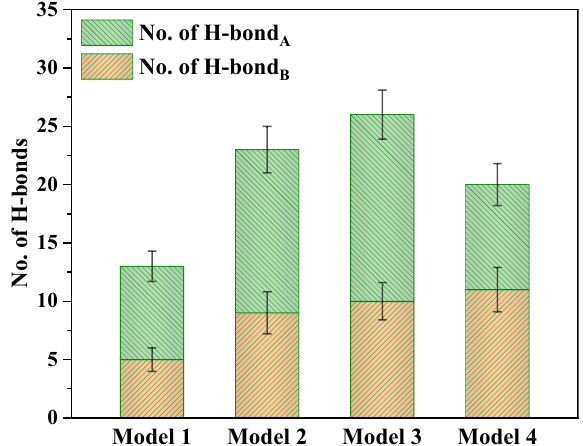
Fig. 4 The number of H-bonds in the different nano-silica/PDMS systems. The error bars stand for the standard deviations from fi ve independent